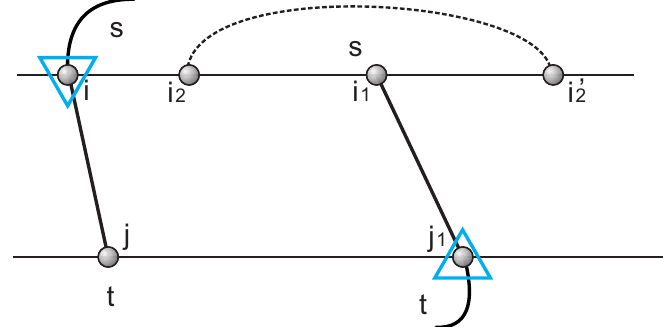
Figure 8. The planarity of a τ -structure. Triangles ∆ and ∆ 1 share the mixed edge, ω = { s , t } and correspond to the φ -arcs ( i , j ) and ( i 1 , j 1 ) . If an S -arc ( i 2 , i (cid:48)